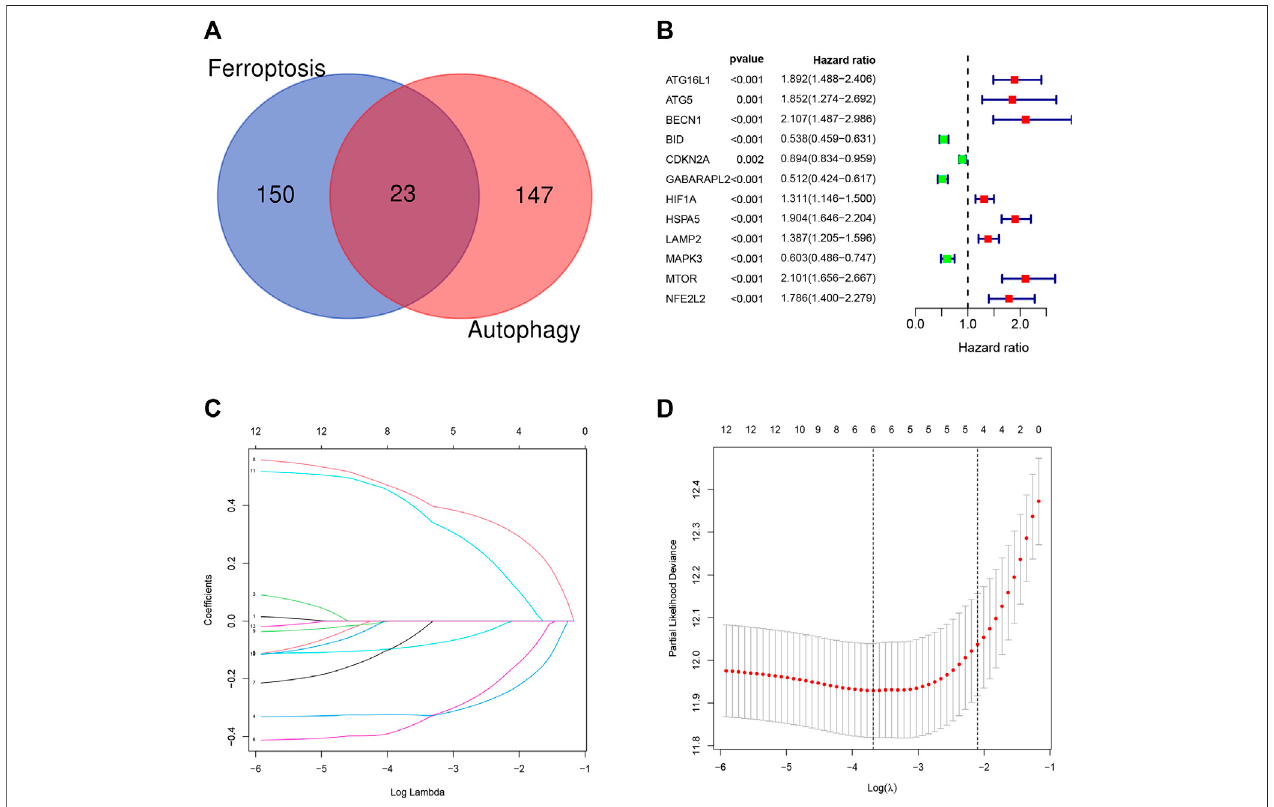
FIGURE 2 | (A) Venn diagram showing that 23 genes have dual functions of autophagy and iron death. (B – D) Univariate and lasso regression screened the best prognosis-related genes.